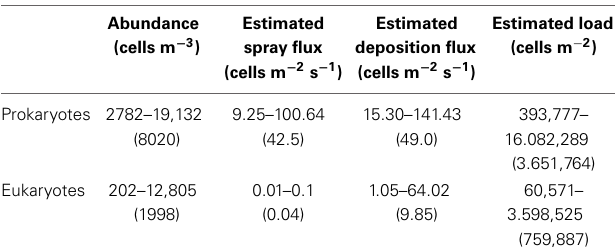
Ocean obtained in this study (range is given in the upper row and averages in the lower